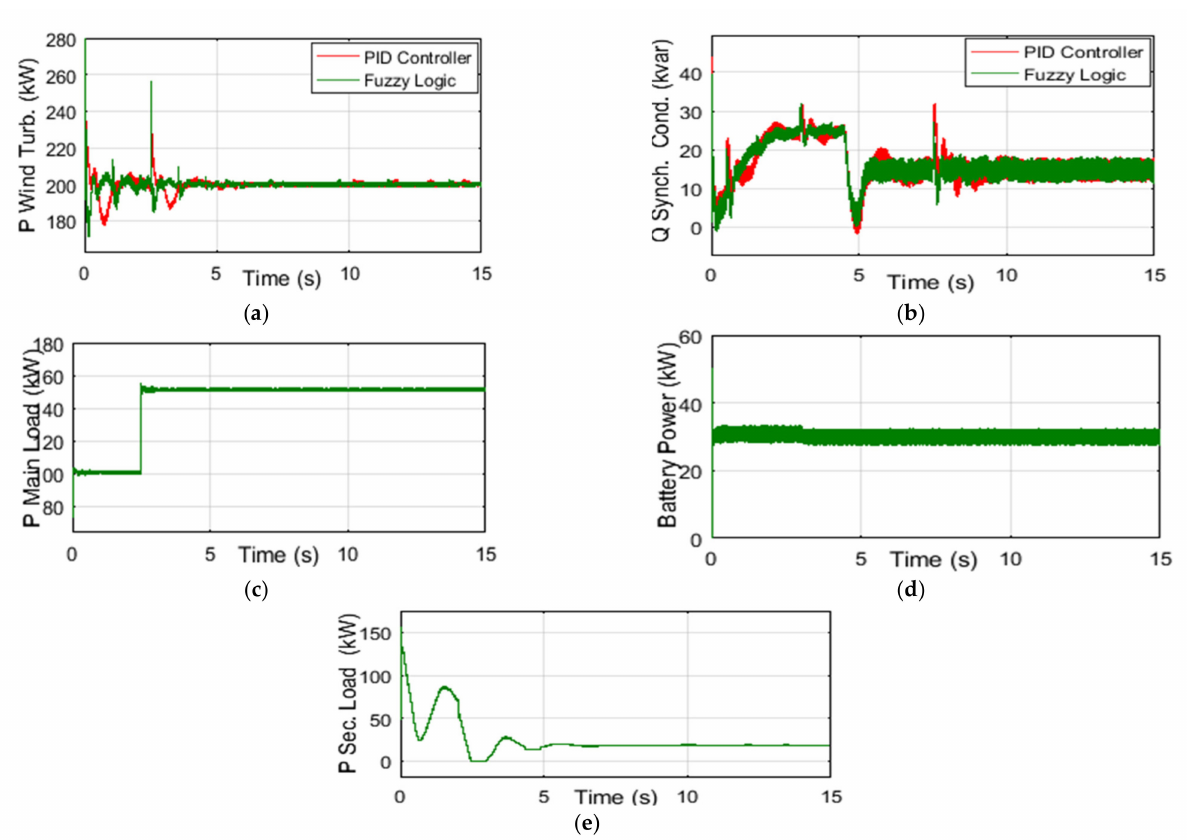
Figure 11. ( a ) The power produced by the wind turbine. ( b ) Reactive power supply from the synchronous condenser. ( c ) Power consumed by consumer load. ( d ) Power supplied from the BESS. ( e ) Power consumed by SL, when the battery is charged.